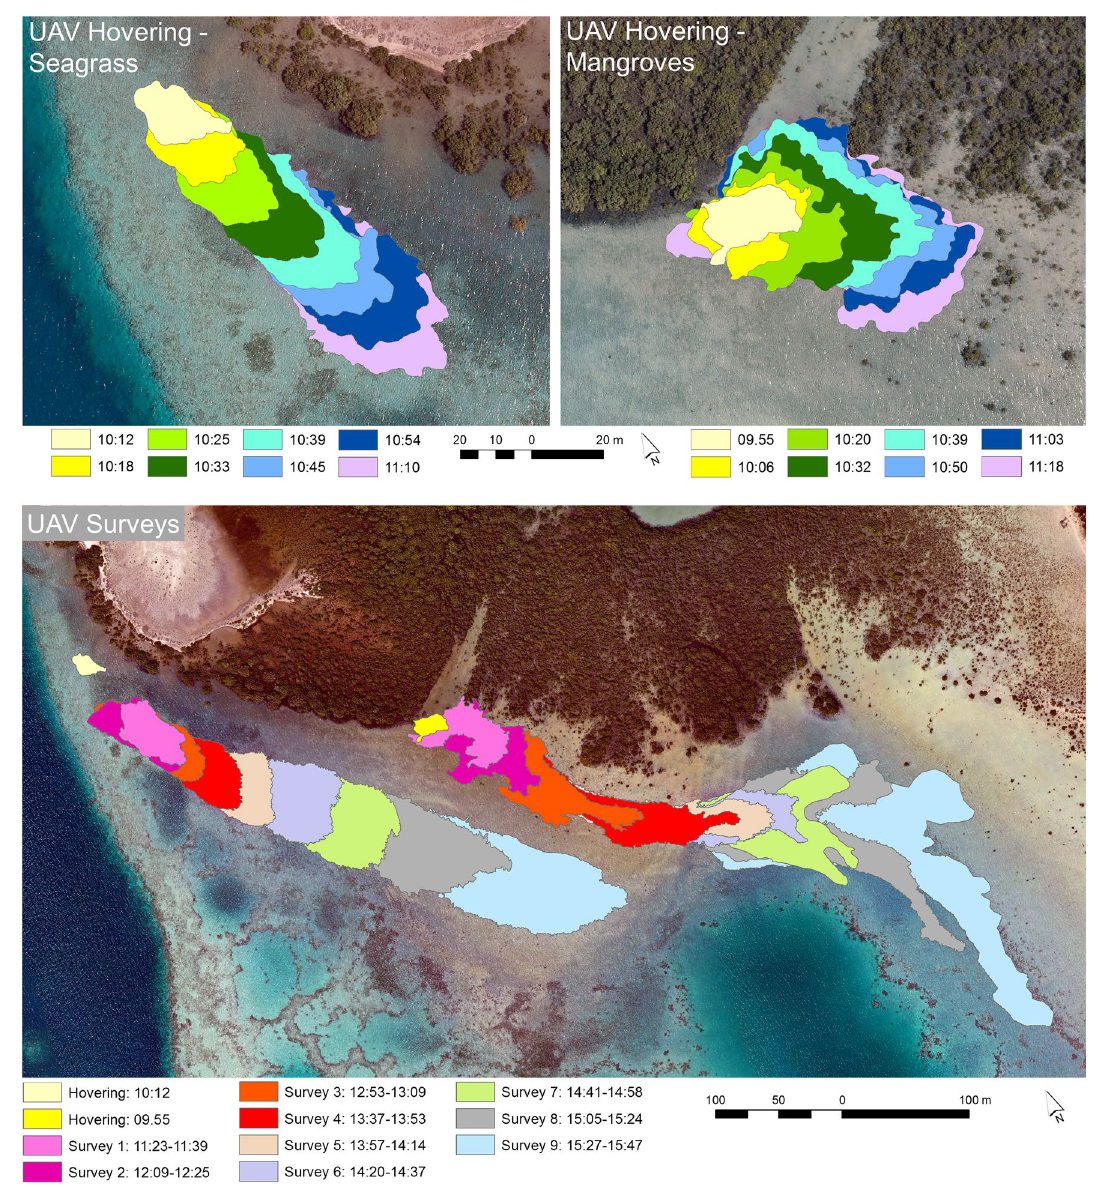
Figure 4. Image time-series of dye plume movement. Movement of the mapped dye plume extents based on eight selected unmanned aerial vehicle (UAV) hovering photos (09:55–11:18) and the orthomosaics of the nine UAV flight surveys (11:23–15:47). Software used to produce the maps: Agisoft Metashape version 1.7.1 (www. agiso ft. com), eCognition Developer version 10.1.1 (https:// geosp atial. trimb le. com/ produ cts- and- solut ions/ ecogn ition) and ArcGIS version 10.5.1 (www. esri. com/ en- us/